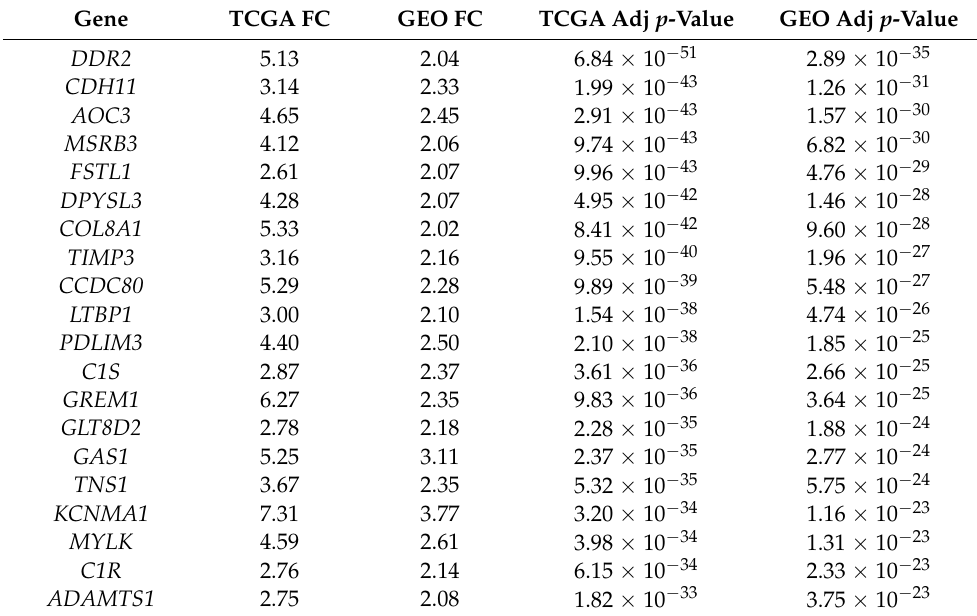
Table 1. Top 20 AKT3 -associated genes after significance and fold-change filtering (FDR adjusted p -value < 0.05 and at least 2-fold up- or down-regulation) in the TCGA and GEO datasets. Expression fold change (FC) and FDR-adjusted p -value are shown per gene, for each data set. Genes are sorted based on the average rank of the adjusted p -value across the two data sets. The full list of 51 AKT3 - specific genes is provided in Table S3.